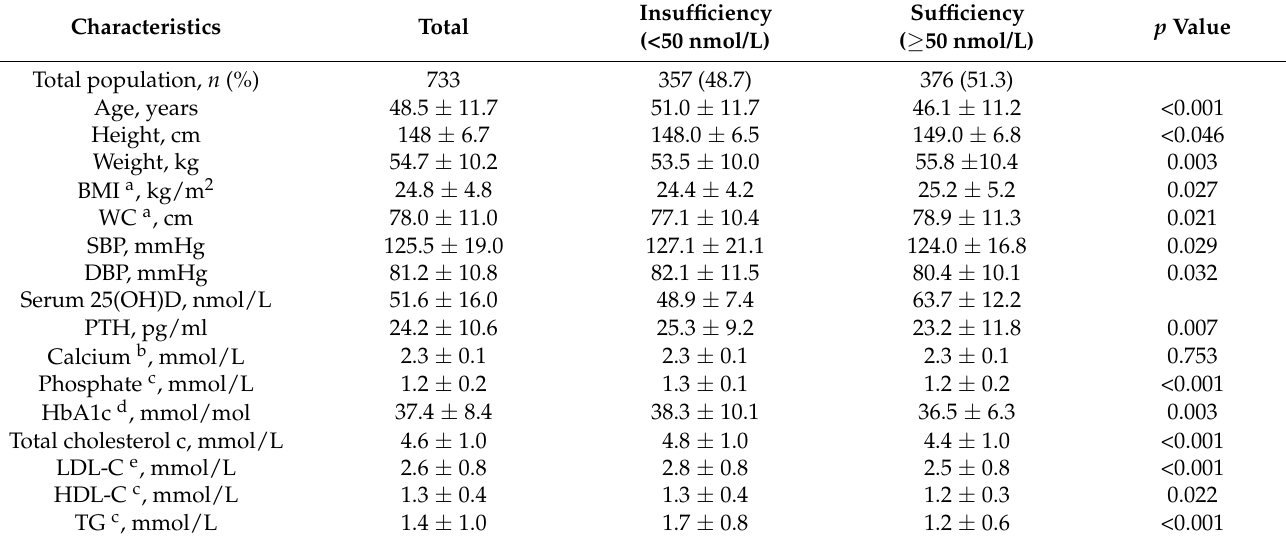
Table 3. Anthropometrics, blood pressure and biochemical parameters stratified by vitamin D